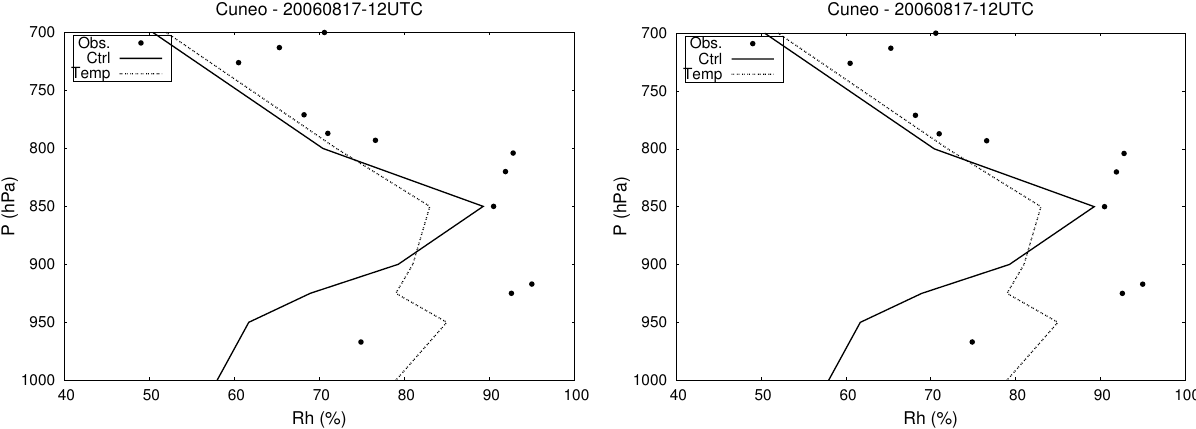
Fig. 14. Vertical relative humidity profile in Cuneo at +12h (left) and +24h (right) for the August 2006 case. The dots represent the observations, the continuous line represents the Ctrl run and the dotted line represents the Temp run.